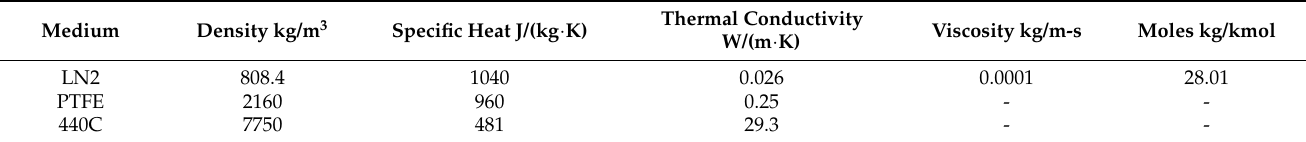
Table 5. Relative parameters of LN2 and bearing materials.